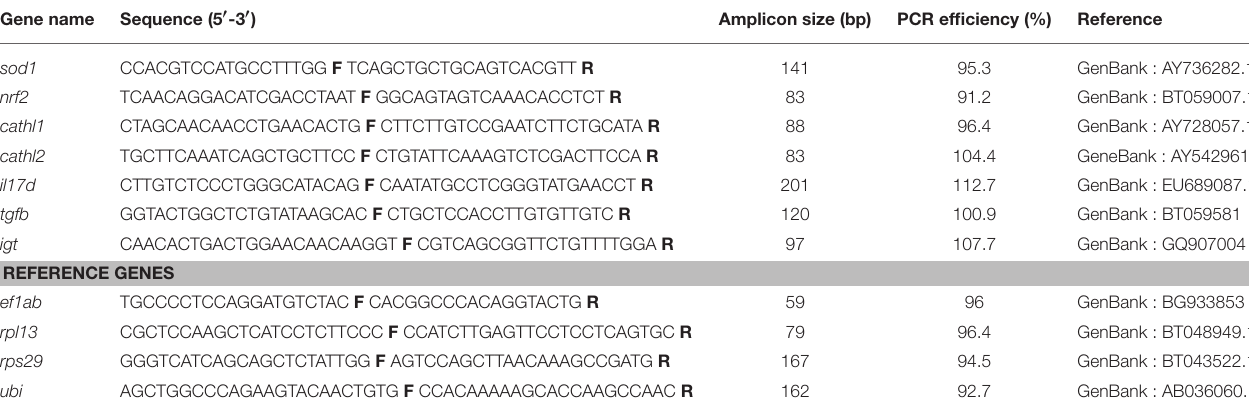
TABLE 2 | List of primers for the differentially expressed genes and reference genes.